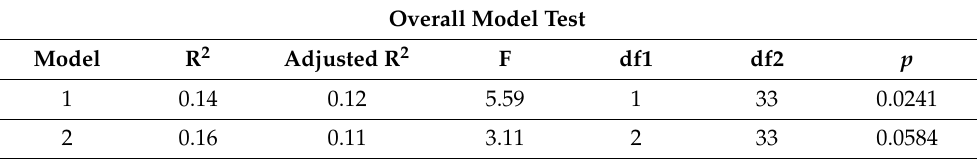
Table 5. Regression analysis on stress and dialysis timing covaried by creatinine